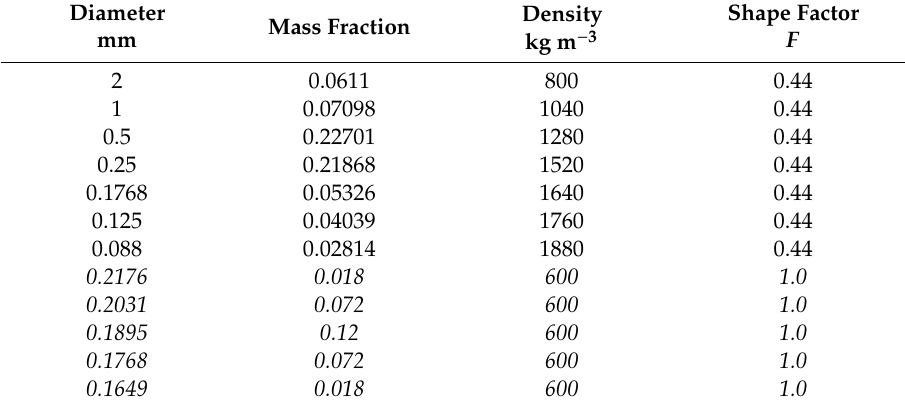
Table 4. Total grain-size distribution (TGSD) used in Calbuco deposit simulations. Rows in italics represent aggregates of fine ash. The TGSD is based on a simplification of the Mount St. Helens 1980 total grain-size distribution [21]. Particle sizes larger than 2 mm are consolidated into the 2 mm bin to speed calculation. The size distribution of aggregates was derived by optimizing the fit between model simulations and four well-mapped deposits [21]. Densities of each size fraction are based on densities of those component sizes at Mount St. Helens. Ash3d uses a fall velocity calculation based on Wilson and Huang [34] in which non-spherical particles are represented as ellipsoids with a shape factor F = ( b + c ) / 2 a , where a , b , and c , are the semi-major, intermediate, and semi-minor axes of the ellipsoid. A shape factor of 0.44 is the average of values of real pyroclasts measured by Wilson and Huang [34]. Shape Factor Diameter Density Mass Fraction F mm kg m − 3 2 0.0611 800